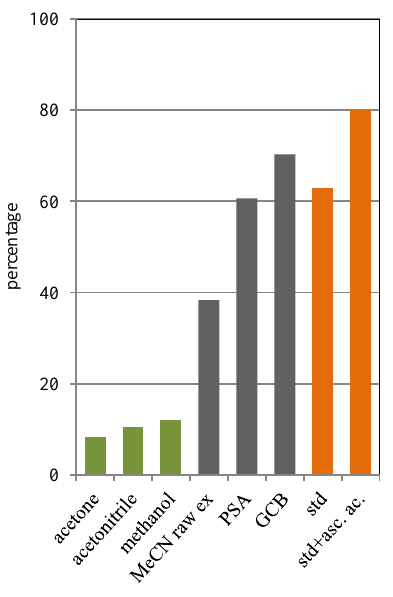
Figure 3. Fucoxanthin content after light exposure expressed as a percentage of the initial content in the conventional extracts (acetone, acetonitrile, methanol; green), in the extracts obtained with the QuEChERS method (acetonitrile raw extract, PSA, GCB; grey) and in standard solutions (with and without ascorbic acid;